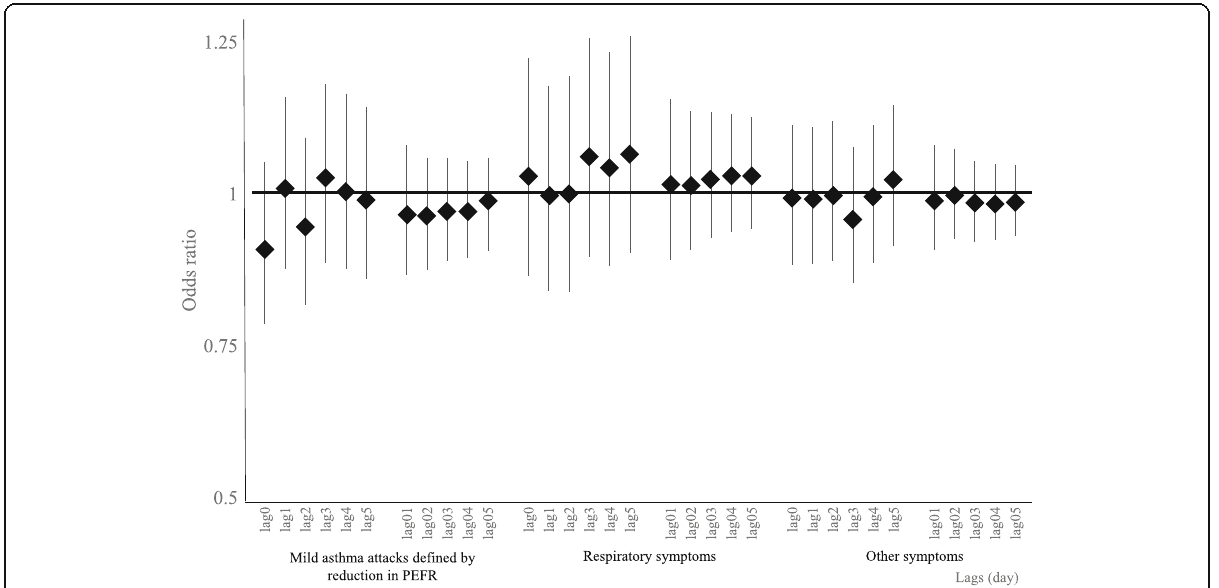
Fig. 4 Association between Asian dust exposure and asthma attack and clinical symptoms (categorical outcomes) using conditional logistic regression models adjusting for temperature and relative humidity. The vertical bars represent 95% confidence intervals. Mild asthma attack was defined when a reduction of PEFR was below 80%. Respiratory symptoms included cough, wheezing, shortness of breath, asthma attacks in exercise, and sleep disturbance due to asthma attacks. Other symptoms included symptoms affecting the eyes, skin, and